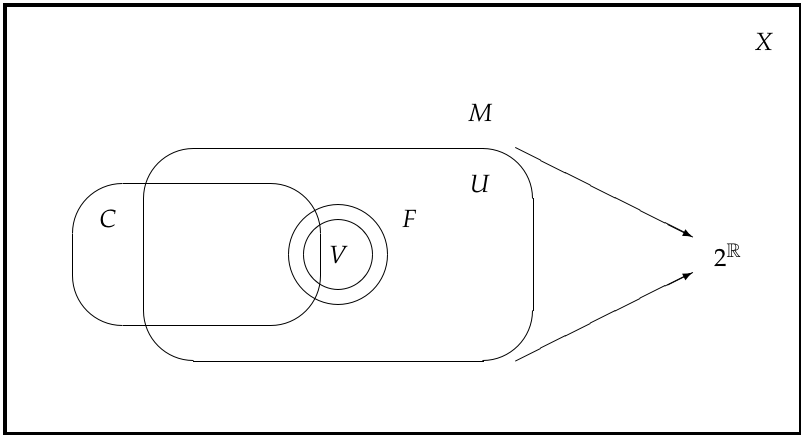
Figure 3. Diagram with the main sets in the arbitrage theory. Source: Own elaboration.